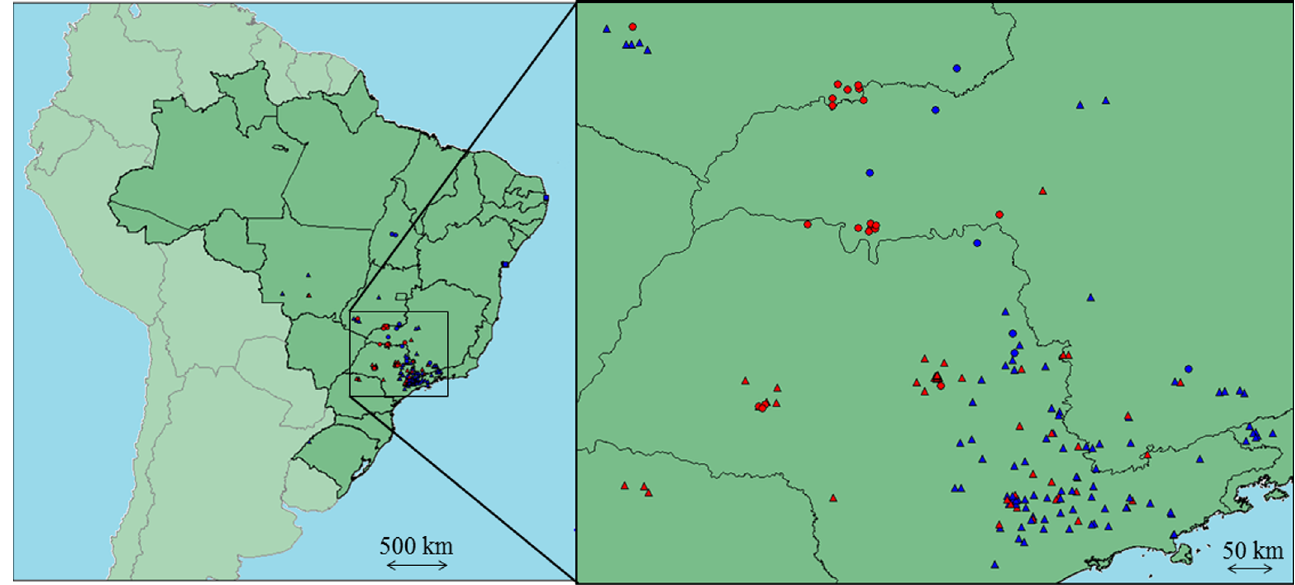
Figure 3. Geographic distribution of C. durissus crotamine-positive (red) and crotamine-negative (blue) in a region of southeast of Brazil. ▲: C. d. terrificus ; ●: C. d. collilineatus